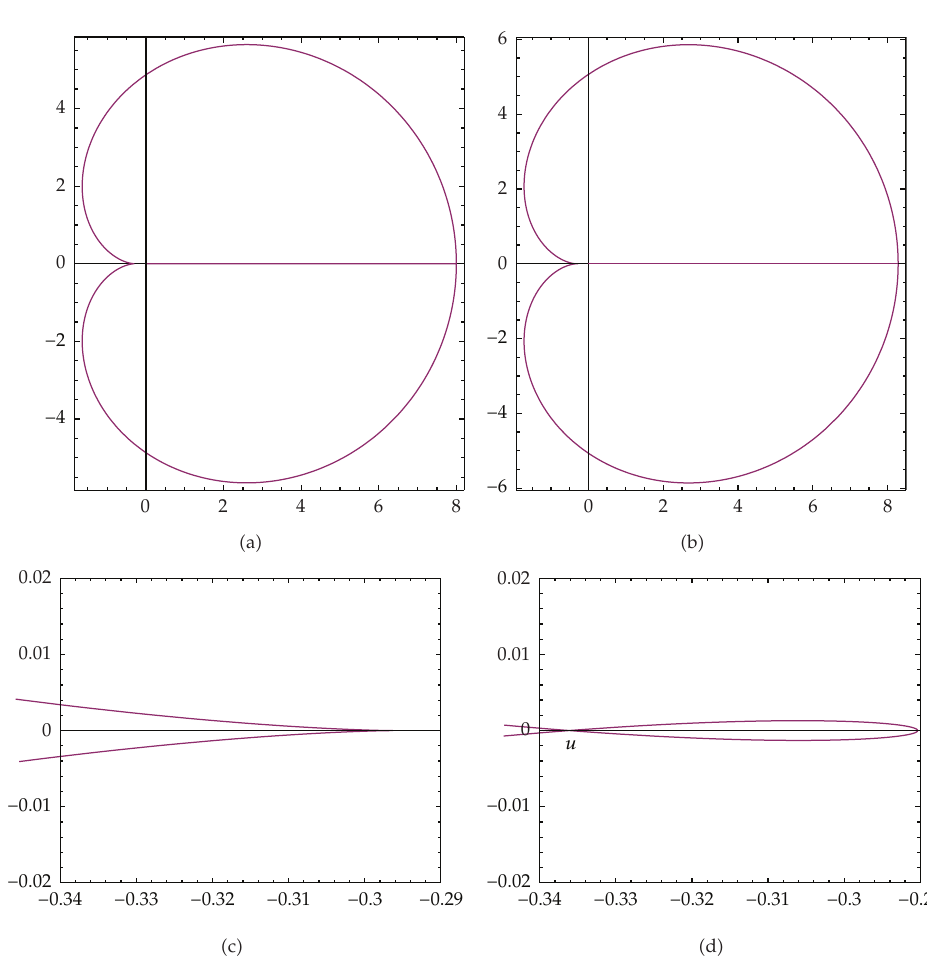
Figure 1: Geometric description for the sharpness of the case n (cid:4)